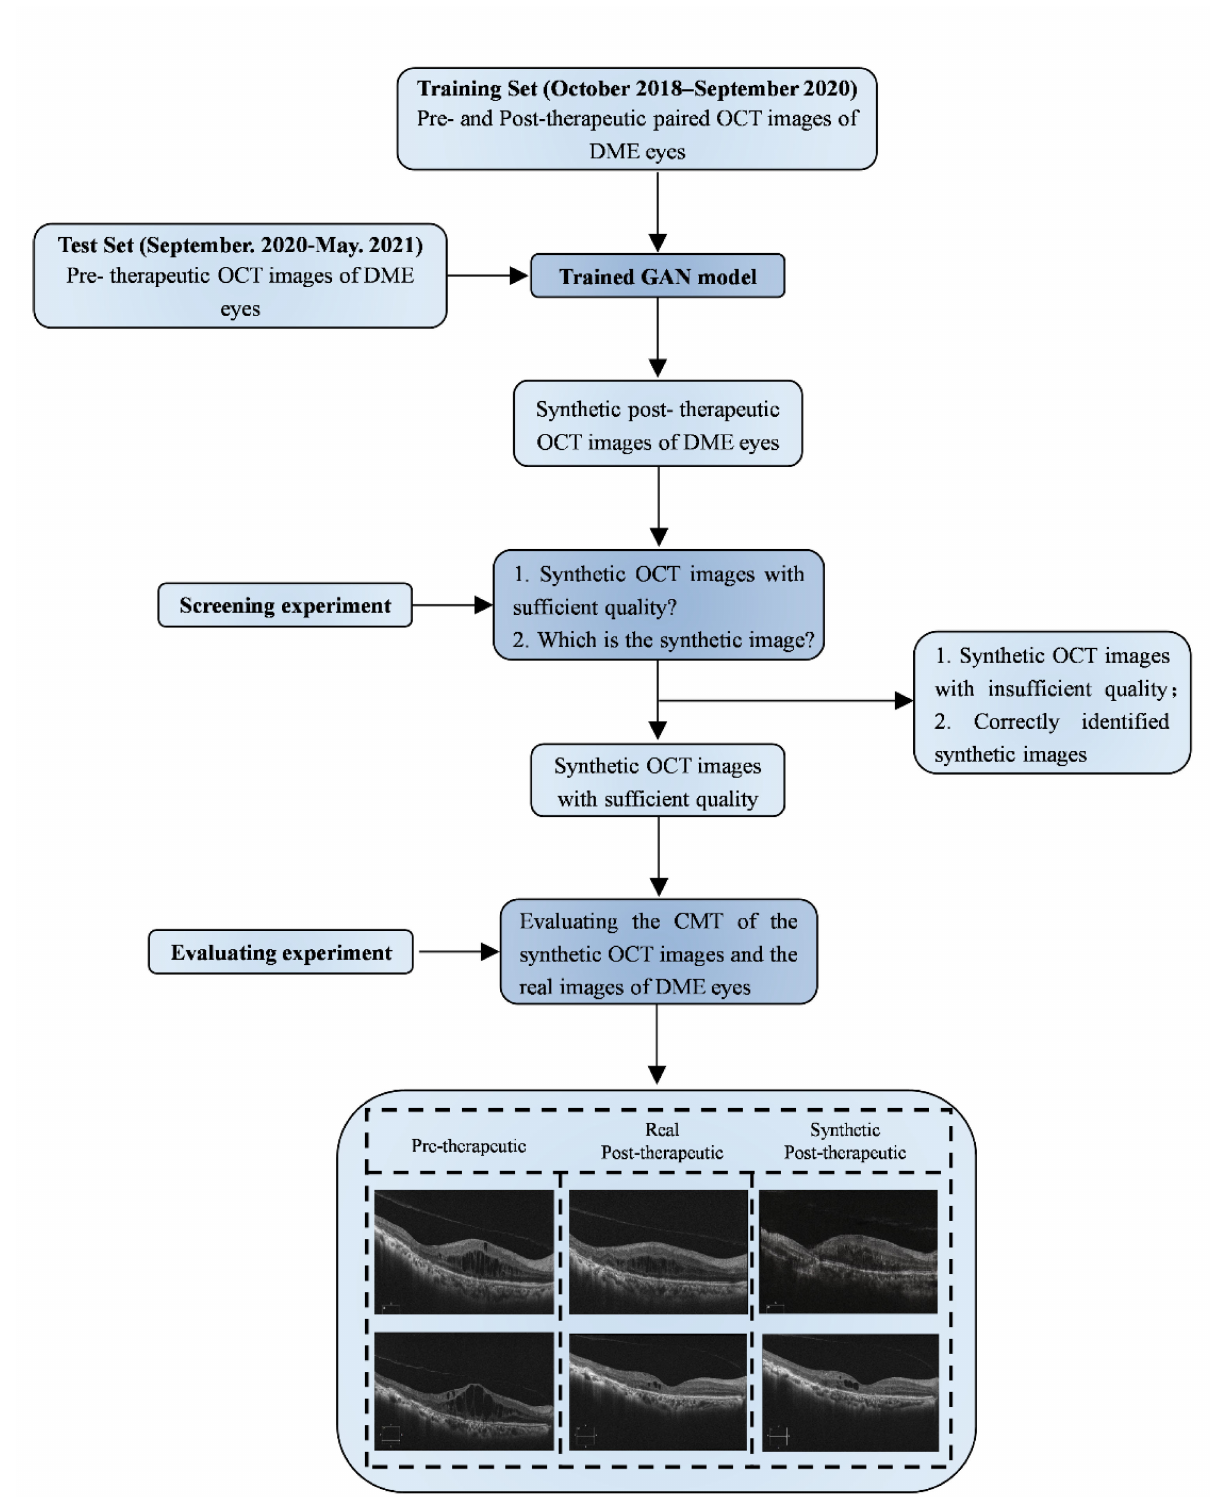
Figure 5. Workflow of our study. OCT, optical coherence tomography; DME, diabetic macular edema; GAN, generative adversarial networks; CMT, central macular